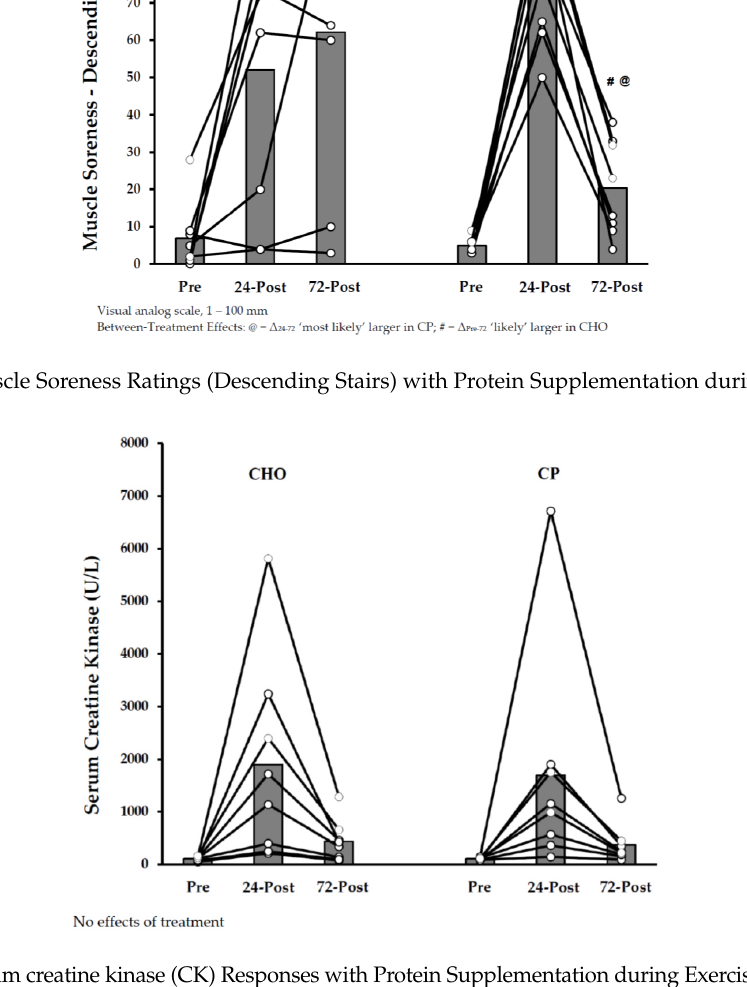
Figure 3. Serum creatine kinase (CK) Responses with Protein Supplementation during Exercise (Study A).